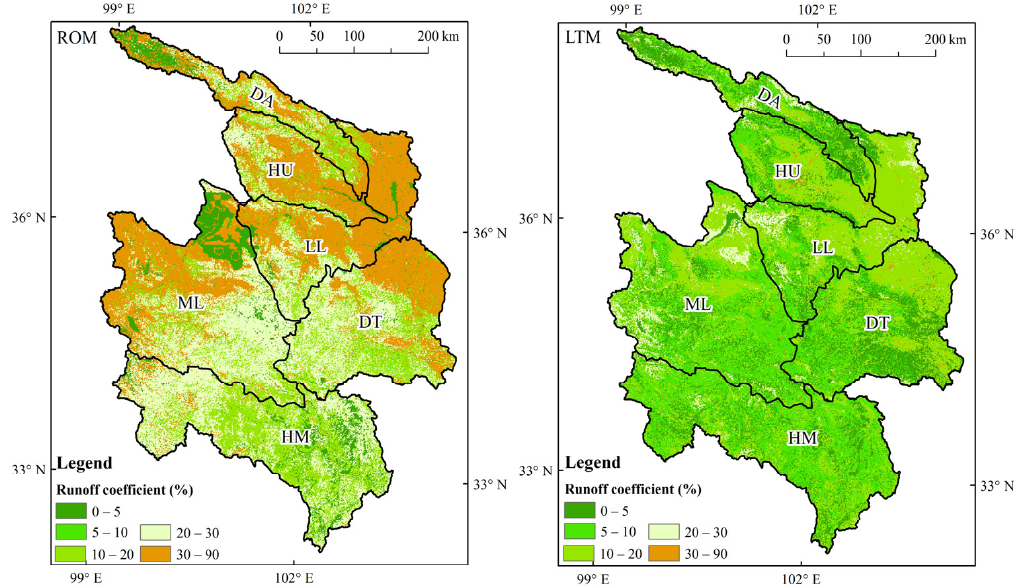
Figure 12. Spatial distribution of runoff coefficient calculated by two methods.